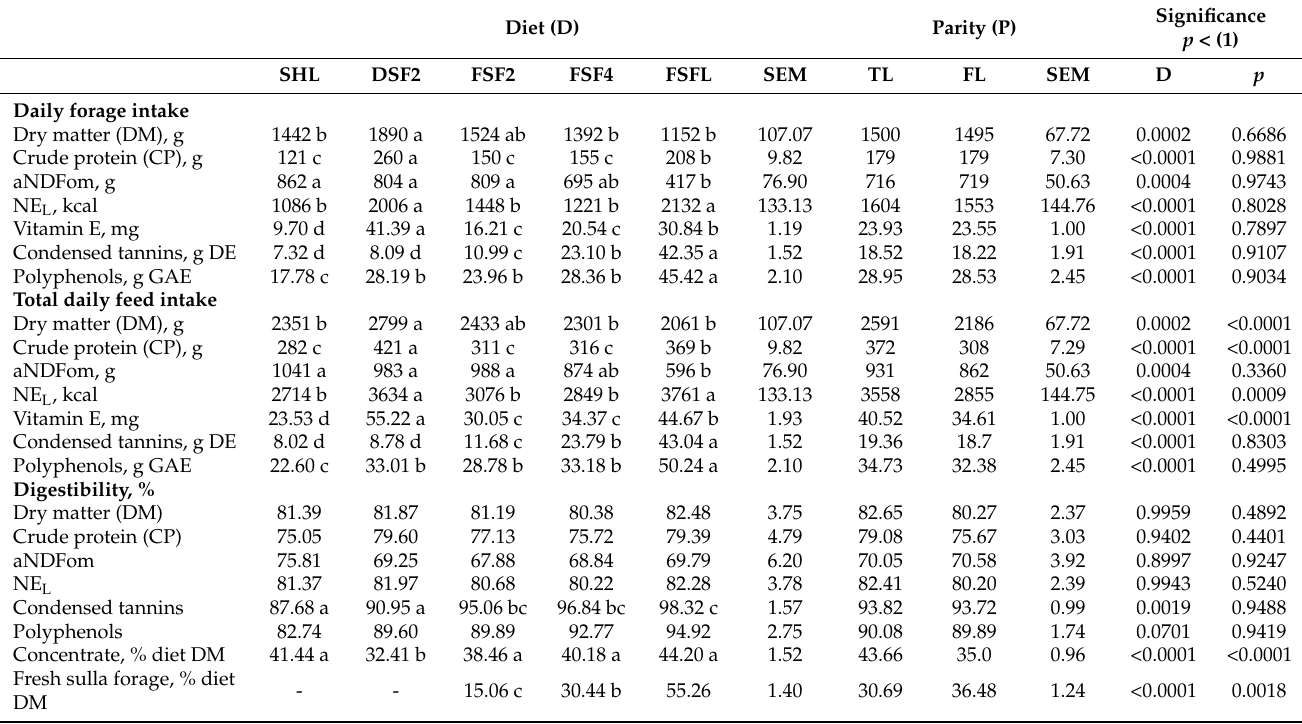
Table 2. Effect of diet and parity on voluntary feed intake and